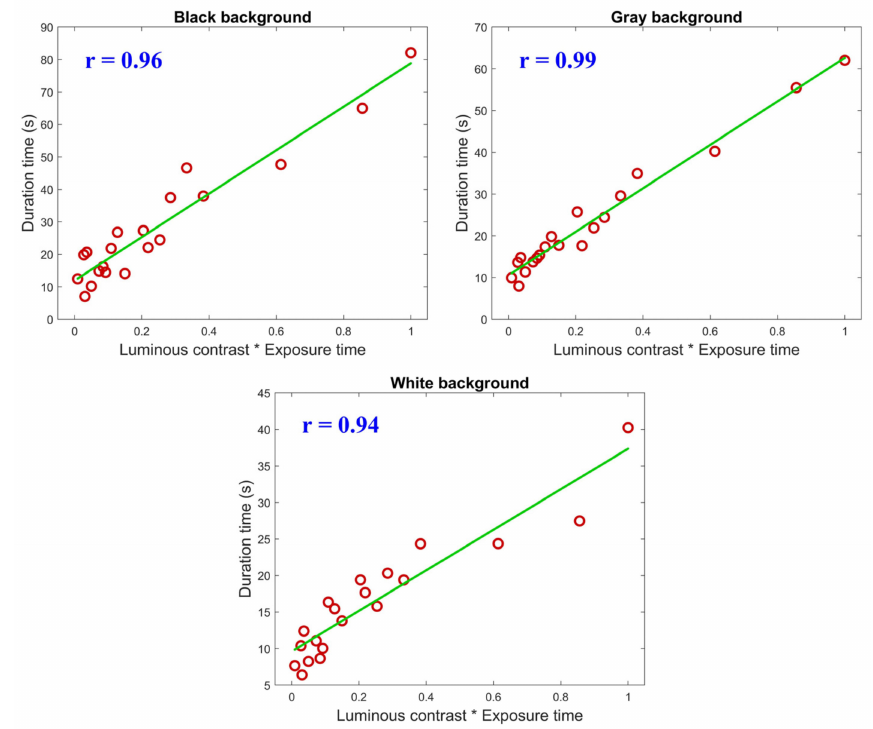
Figure 9. Relationship between the duration and luminance contrast with exposure time.